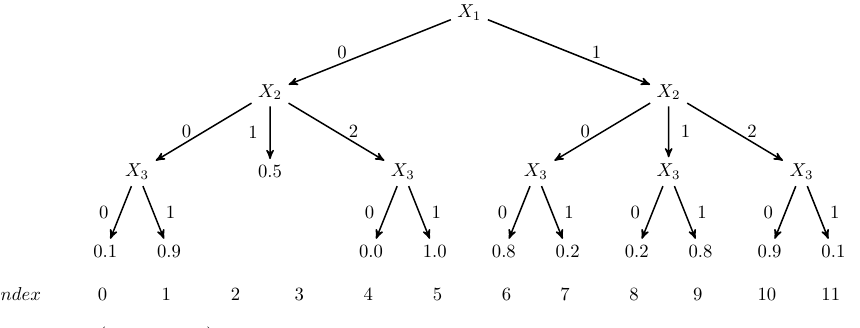
Figure 4. φ ( X 1 , X 2 , X 3 ) as PPT .